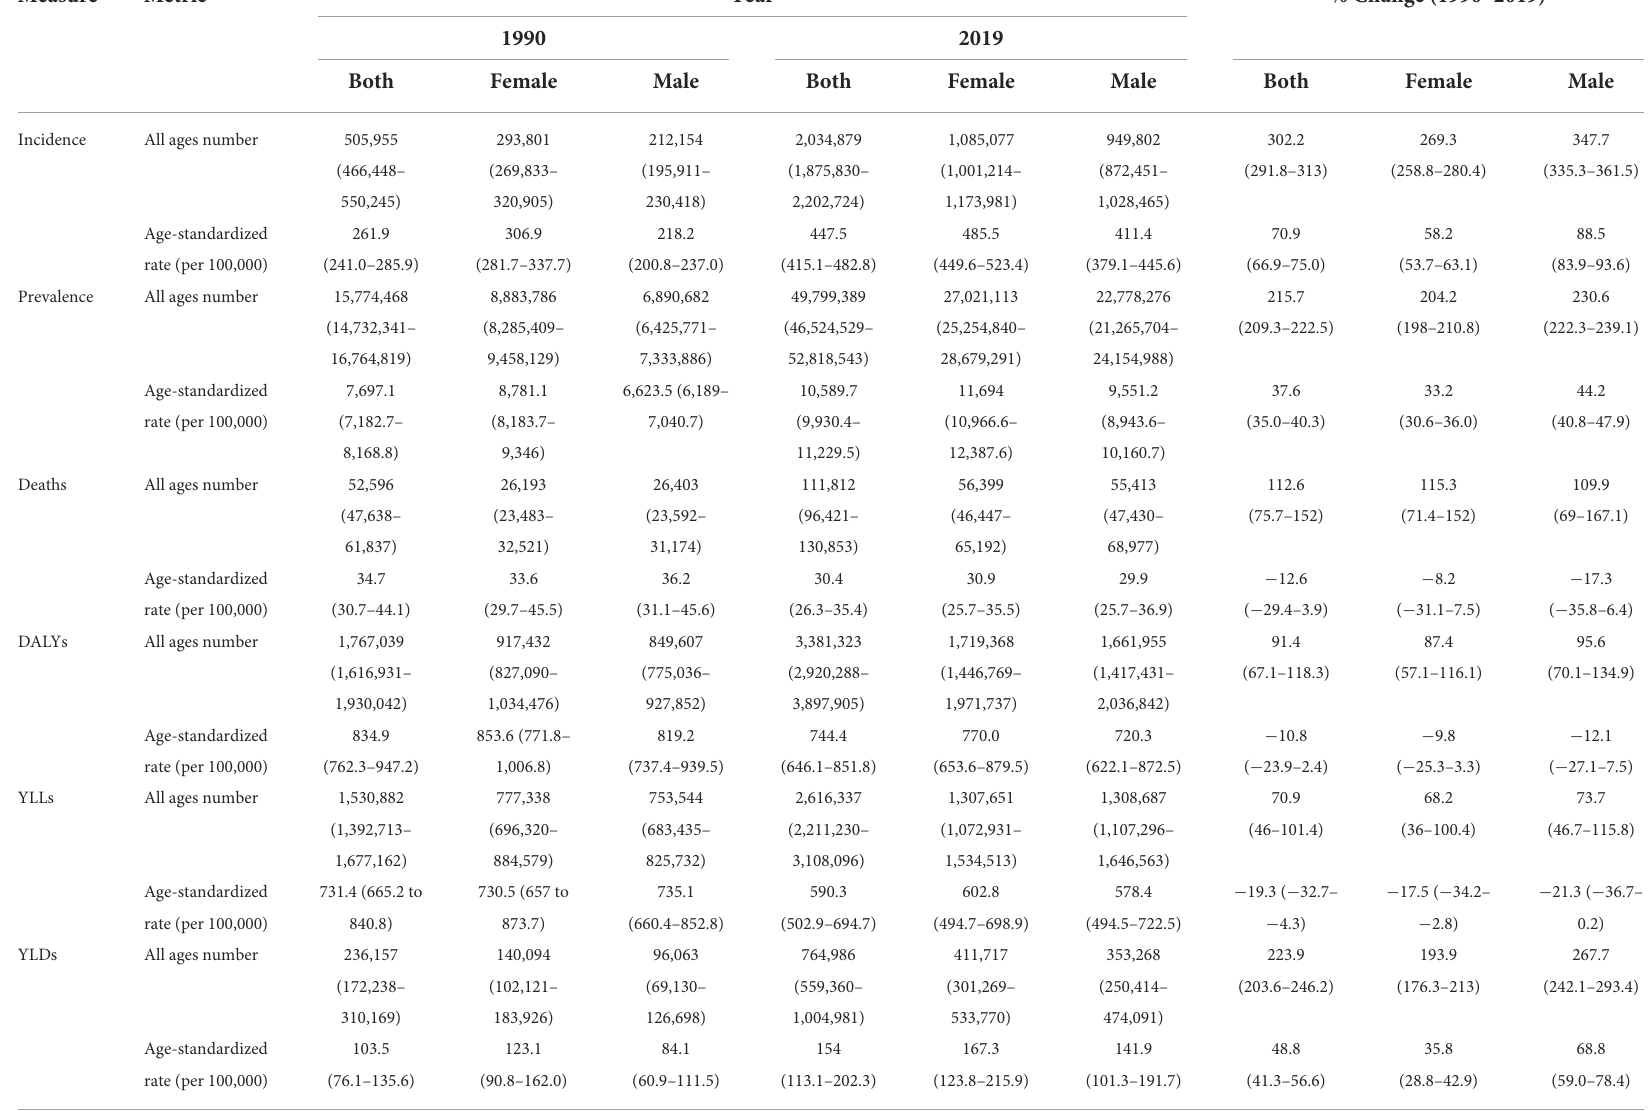
TABLE 1 All ages number and age-standardized rate of health measures of CKD based on sex during 1990–2019 in NAME